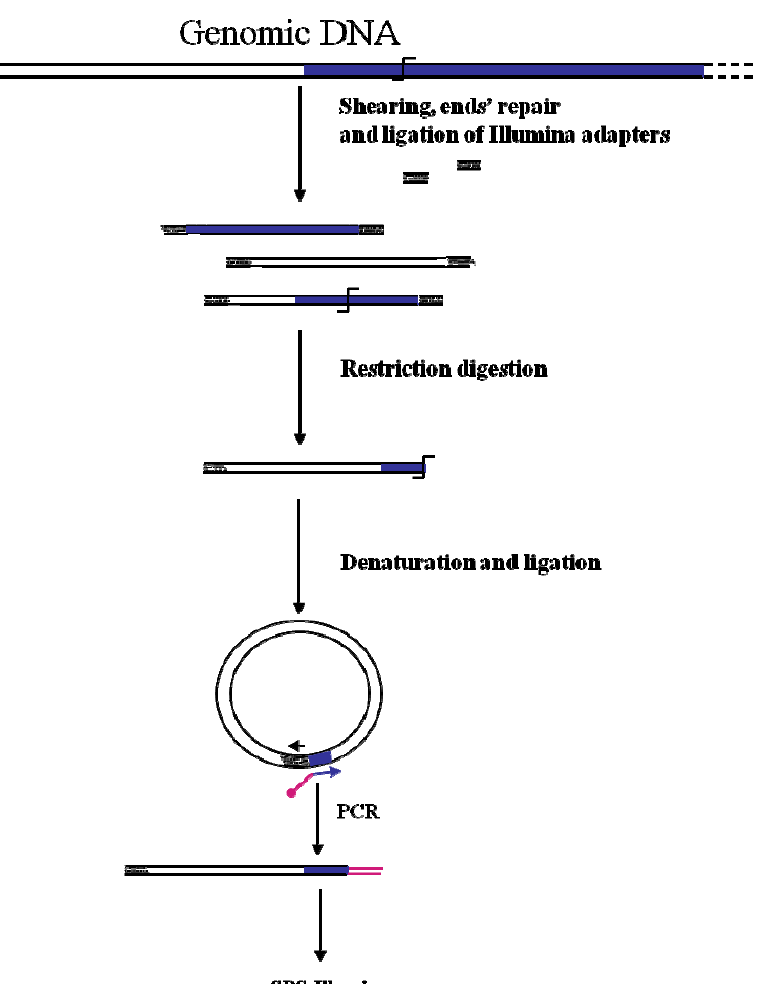
Figure 5. Main steps of Inverted-PCR GW and SBS-Illumina association strategy. Blue and white bars correspond to known and unknown sequences, respectively. An open vertical arrow indicates the MmeI recognition site. The symbol indicates a restriction site. A black horizontal arrow indicates adapter specific primers; a blue arrow represents primers designed in the known region. The Illumina sequencing trait of longer amplification primers is indicated in the